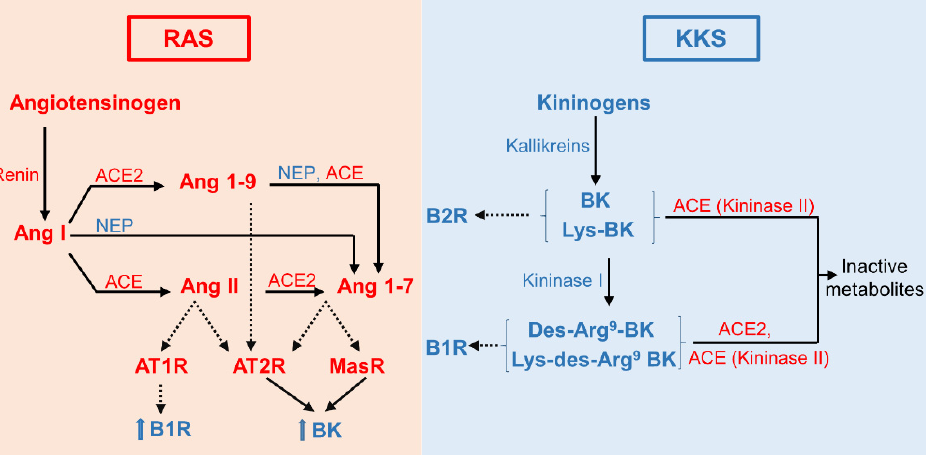
Figure 4. Crosstalk between the kallikrein–kinin system (KKS) and the renin–angiotensin system (RAS). ACE, angiotensin -1 -converting enzyme (kininase II); ACE2, angiotensin-converting enzyme 2; Ang I, angiotensin I; Ang II, angiotensin II; AT1R, angiotensin type 1 receptor; AT2R, angiotensin type 2 receptor; BK, bradykinin; MasR, Mas receptor; NEP, neutral endopeptidase 24.11 (neprilysin, NEP).